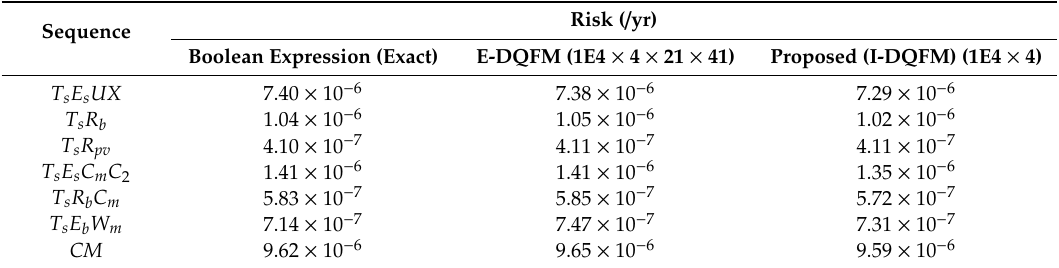
Figure 15. Comparison of multi-hazard system fragility results (“CM sequence”) regarding the LGS NPP example ((2) fully dependent condition): ( a ) Boolean; ( b ) E-DQFM; ( c ) proposed (I-DQFM). Table 7. Mean multi-hazard risk for “LGS NPP”: Independent case.